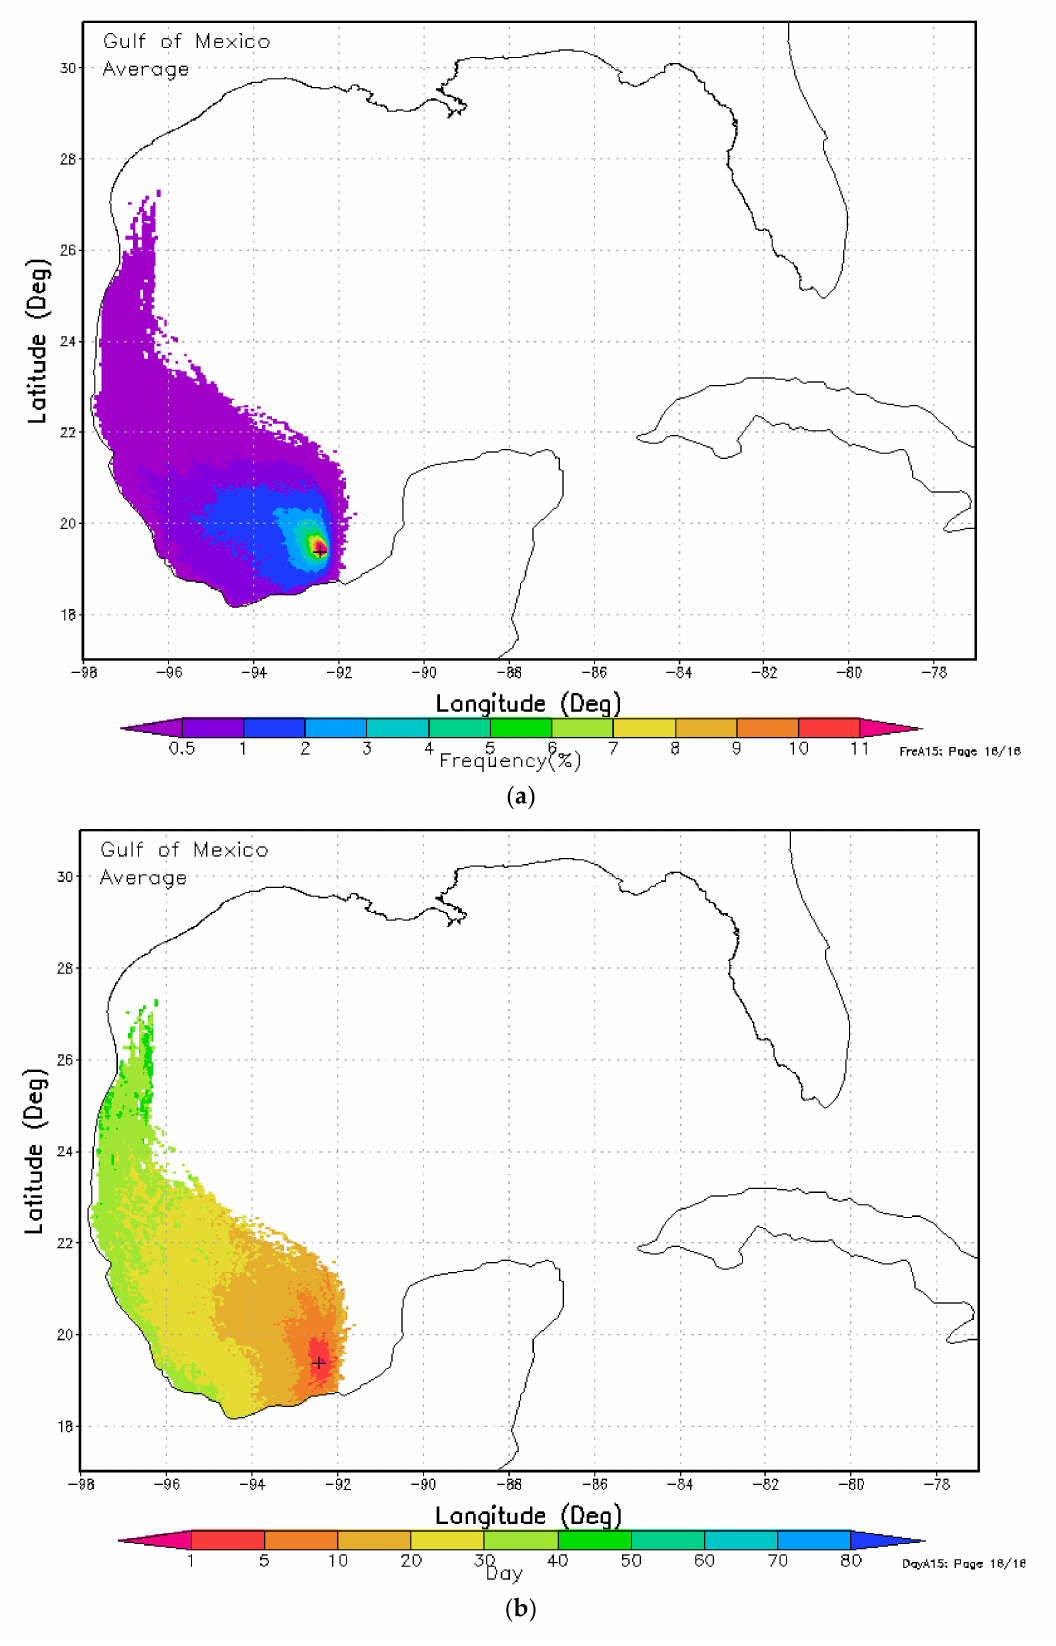
Figure 10. ( a ) The same as Figure 8a, except the half-life time is set to 15 days. ( b ) The same as Figure 8b, except the half-life time is set to 15